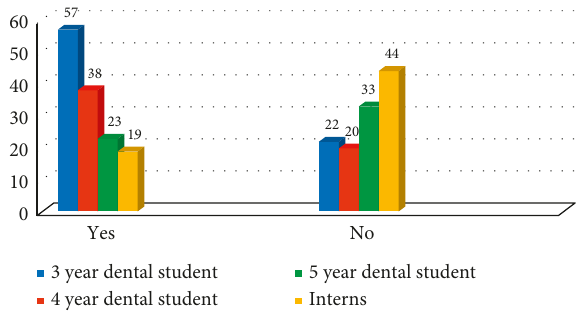
Figure 7: Knowledge of participants toward ionizing radiation effects on healthy tissue ( χ 2